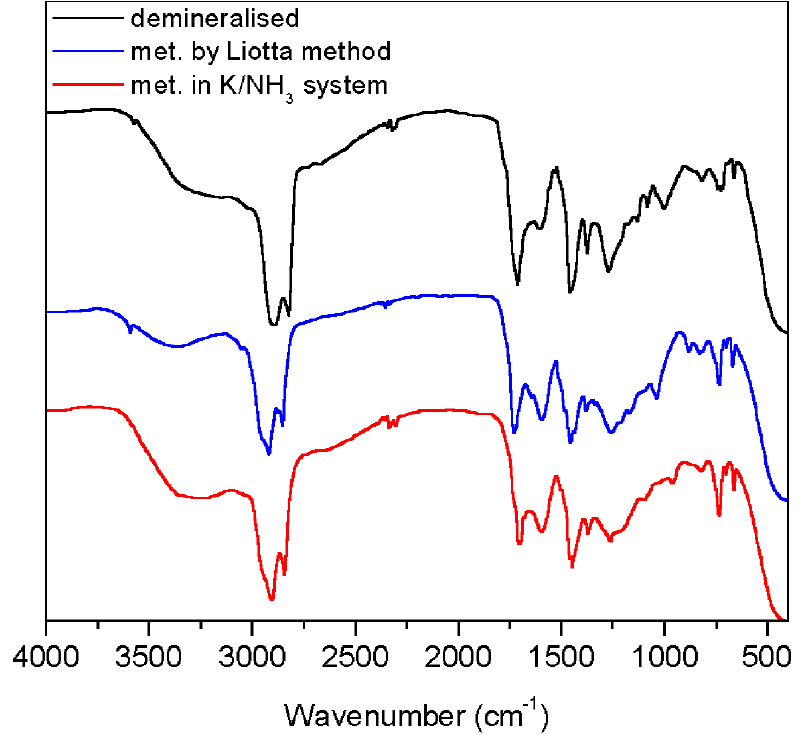
Fig. 1 IR spectra of CH 2 Cl 2 extracts of Mequinenza